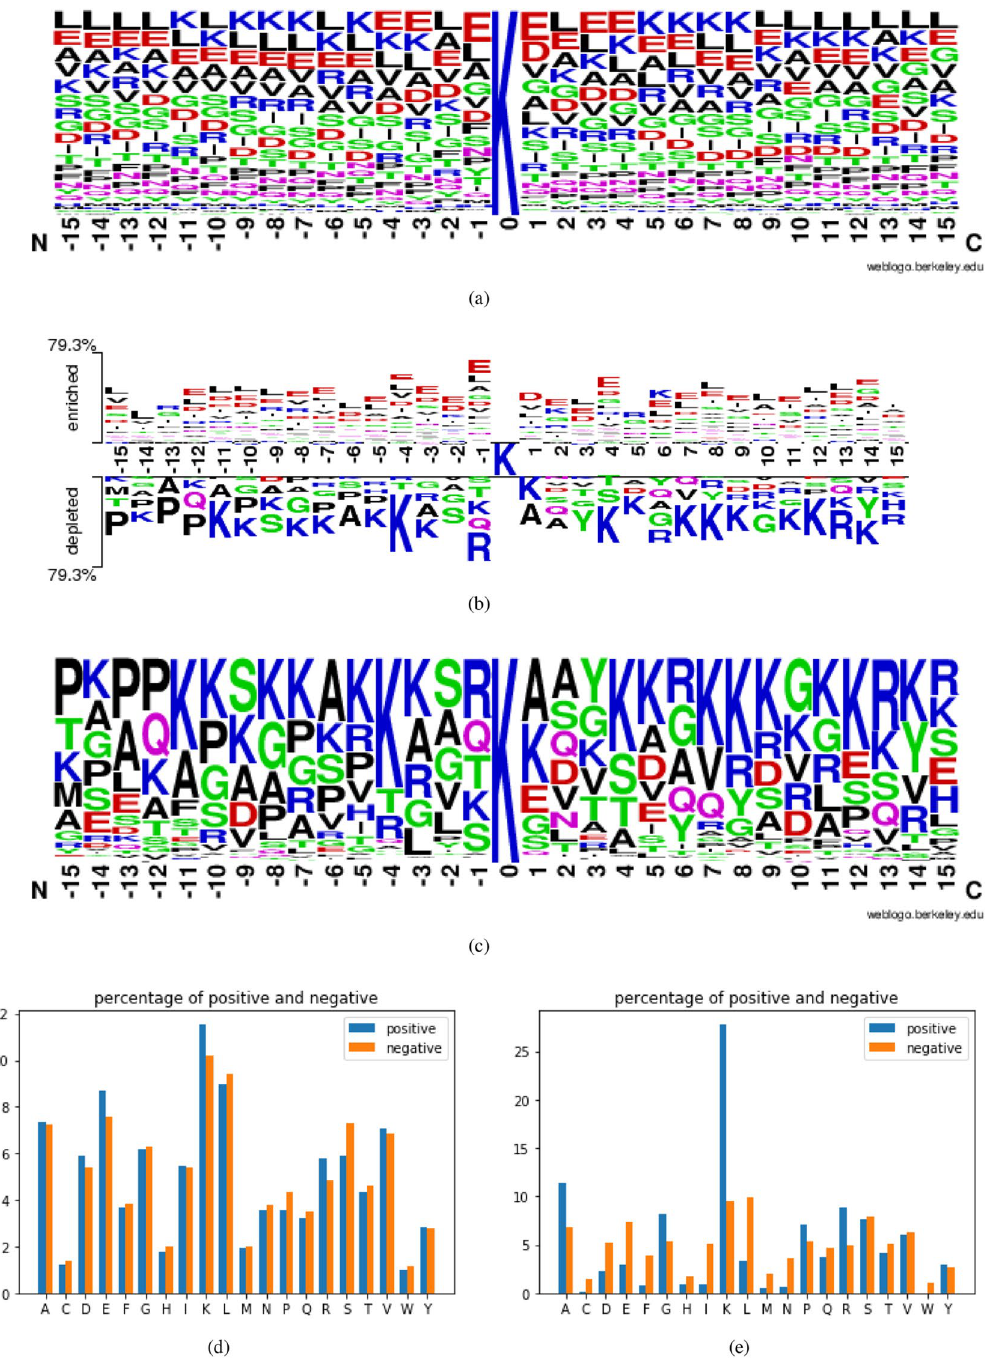
Figure 1. Position-specific amino acid composition analysis of crotonylated sequences and non-crotonylated sequences in plant dataset. ( a ) Indicates the Position-specific amino acid composition of crotonylated sequences in plant dataset based on the frequency plot of WebLogo. ( b ) Shows the Comparison of position-specific amino acid composition between crotonylated sequences in plant dataset (upper part) and crotonylated sequences in mammalian dataset (lower part) based on TwoSampleLogo. ( c ) Indicates the Position-specific amino acid composition of crotonylated sequences in mammalian dataset based on the frequency plot of WebLogo. ( d ) and ( e ) Shows the statistics of each amino acid composition (AAC) in plant and mammalian dataset respectively. From ( d ) it can be seen that large differences exist in the composition of K, E and S in plant dataset, and from ( e ) great differences exist among the composition of K, L, A, D, E and N in the dataset of